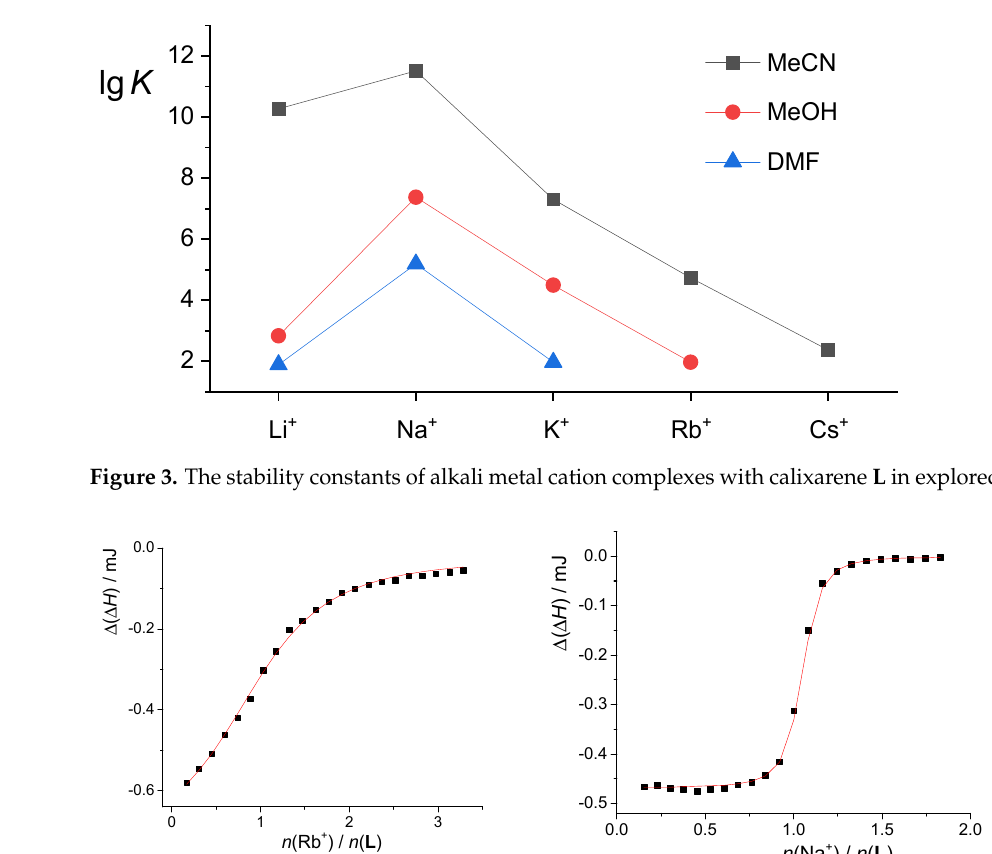
Figure 4. Microcalorimetric titration of: ( a ) L ( c = 7.77 × 10 − 5 mol dm − 3 , V = 1.42 mL) with RbI ( c = 2.60 × 10 − 3 mol dm − 3 ) and ( b ) K L + ( c ( L ) = 2.14 × 10 − 4 mol dm − 3 , c (KClO V = 1.43 mL) with NaClO 4 ( c = 2.02 × 10 − 3 mol dm − 3 ) in acetonitrile at 25 °C; ■ experimental; ― calculated.